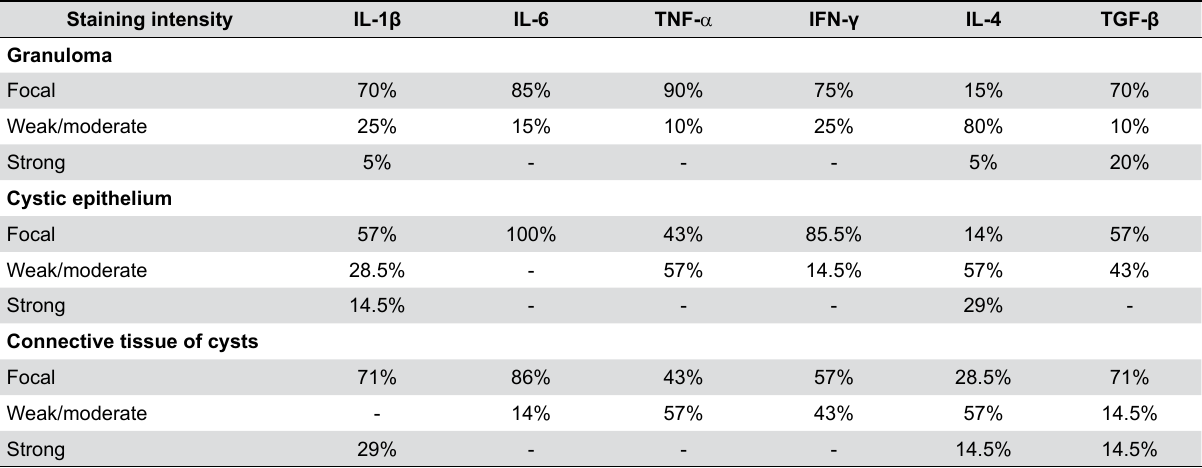
Table 2- Expression of pro-inflammatory and anti-inflammatory cytokines in post-treatment apical periodontitis